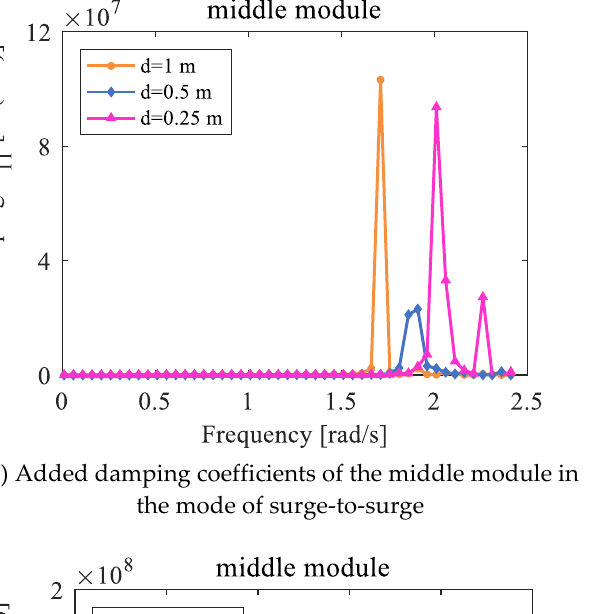
under the condition of a small gap i.e., with spacing less than 1 m. In order to improve the